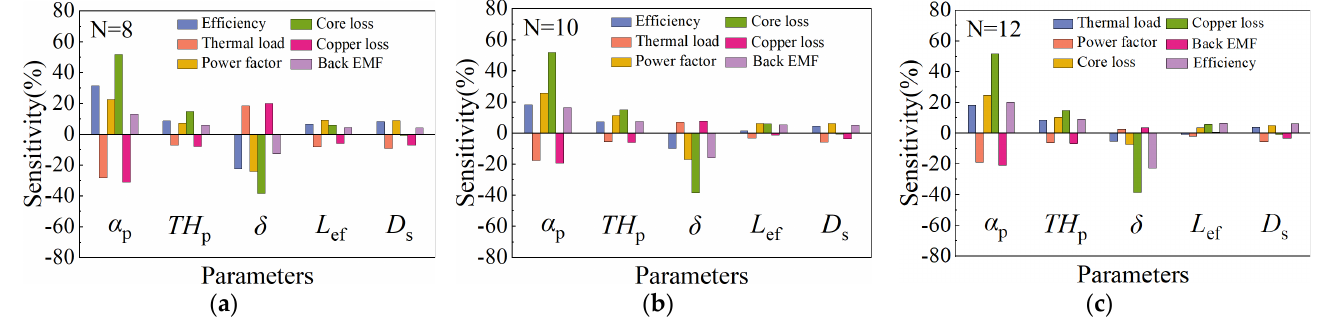
Figure 9. Response surface of air gap length and stator outer diameter to electromagnetic perfor ‐ mance parameters. ( a ) Back EMF; ( b ) copper loss; ( c ) thermal load.